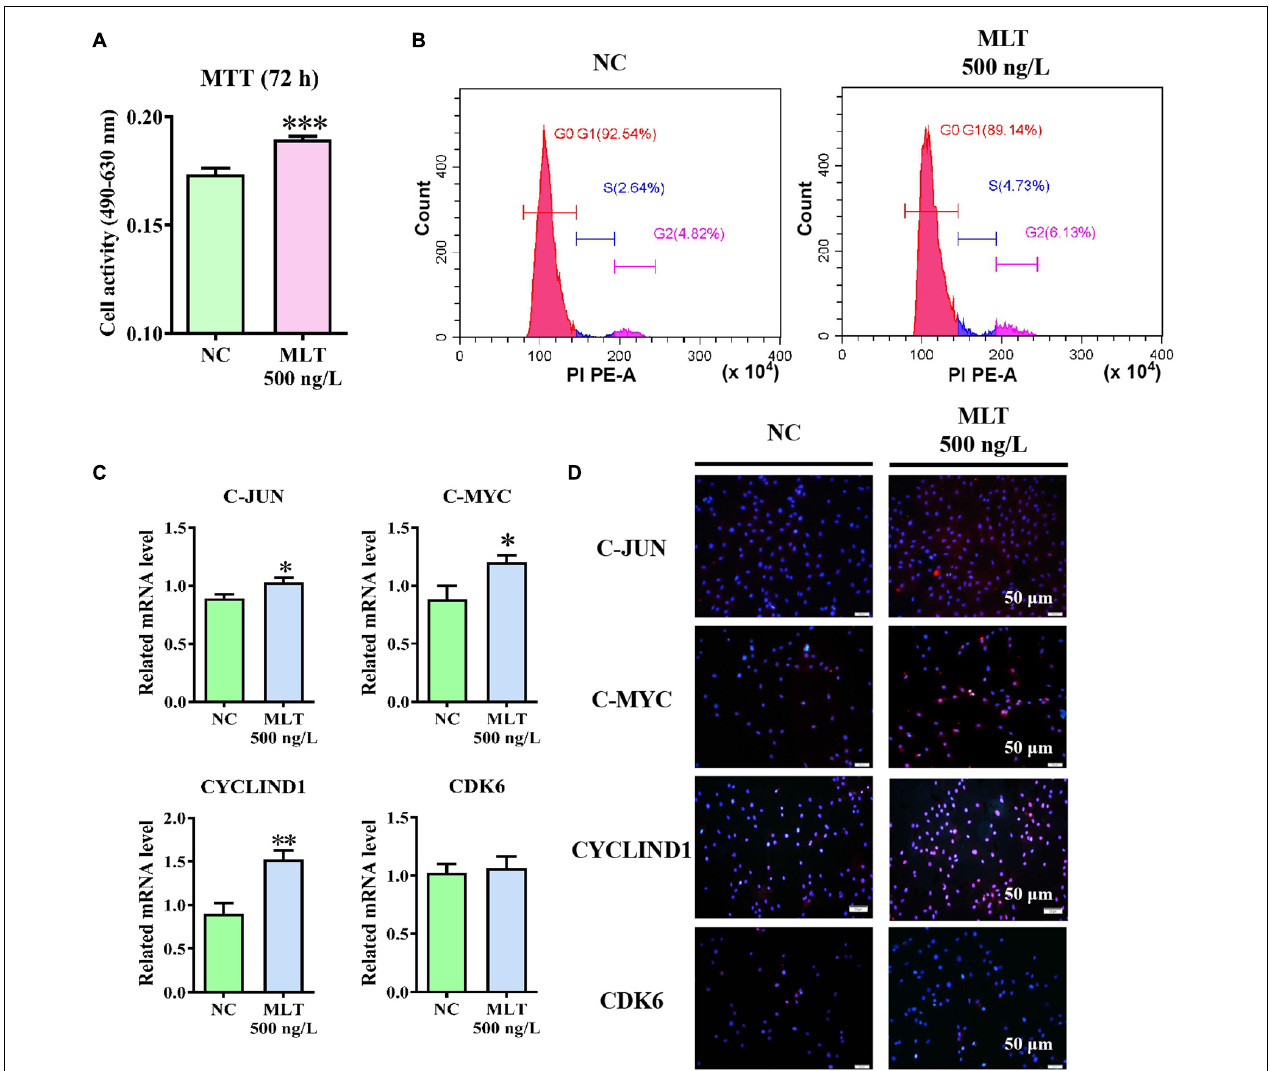
FIGURE 4 | Melatonin promoted the proliferation and cell cycle of gsHFSCs by promoting Wnt downstream factor expression, ∗∗∗ p < 0.001. (A) MTT analysis of melatonin on gsHFSCs proliferation following 72 h of exposure. (B) Cell cycle analysis of gsHFSCs after melatonin exposure at 72 h. (C) Relative mRNA level of C-JUN , C-MYC, CYCLIND1, and CDK6 as detected by RT-qPCR after melatonin exposure for 72 h; ∗∗ p < 0.01, ∗ p < 0.05 (Control: green; 72 h melatonin: blue). (D) Proteins tested by immunofluorescence staining. Scale bar, 50 µ